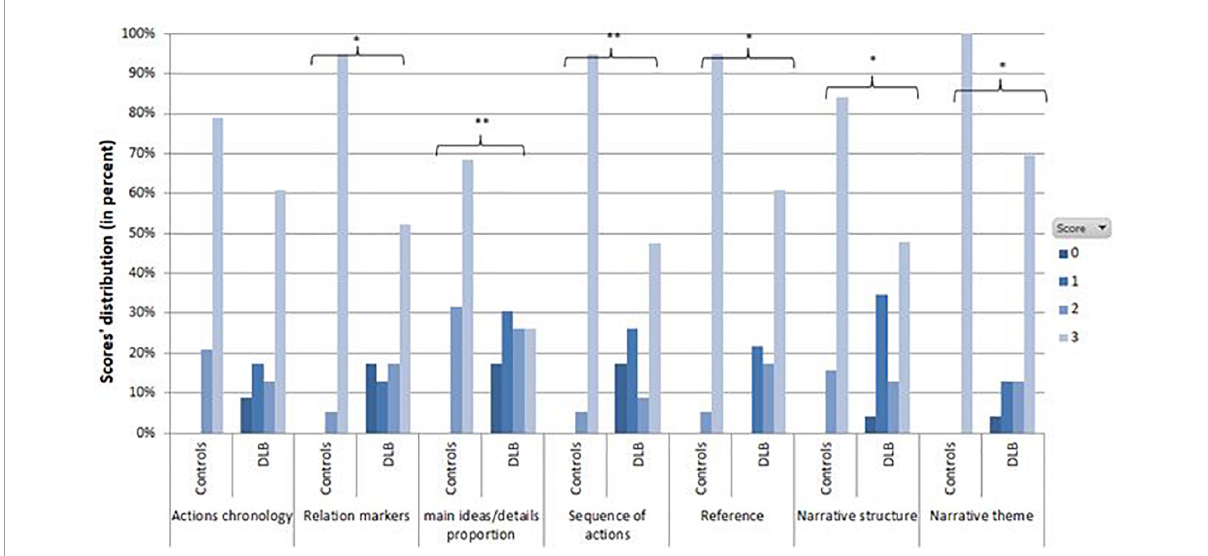
FIGURE1 Distribution of each sub-item of narrative coherence in DLB patients and controls (Significance: * p < 0.05; ** p < 0.001).